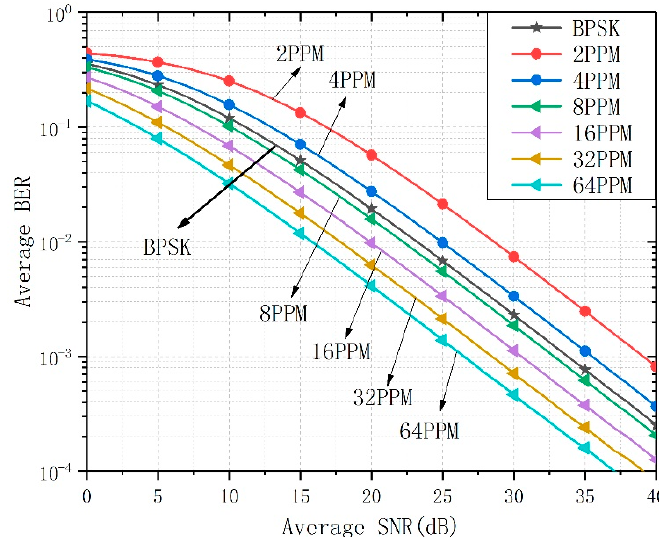
1 =ξ . Turbulence parameters